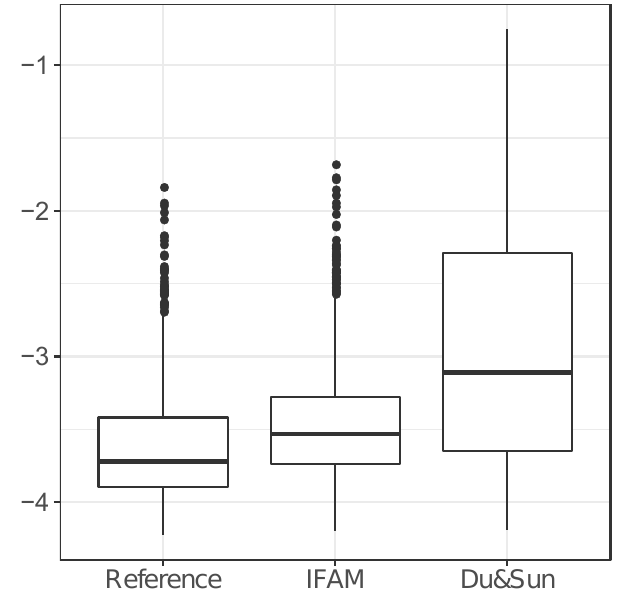
Figure 7. Boxplots of log M-values obtained from a reference library, simulated aggregates using IFAM and Du and Sun’s method.